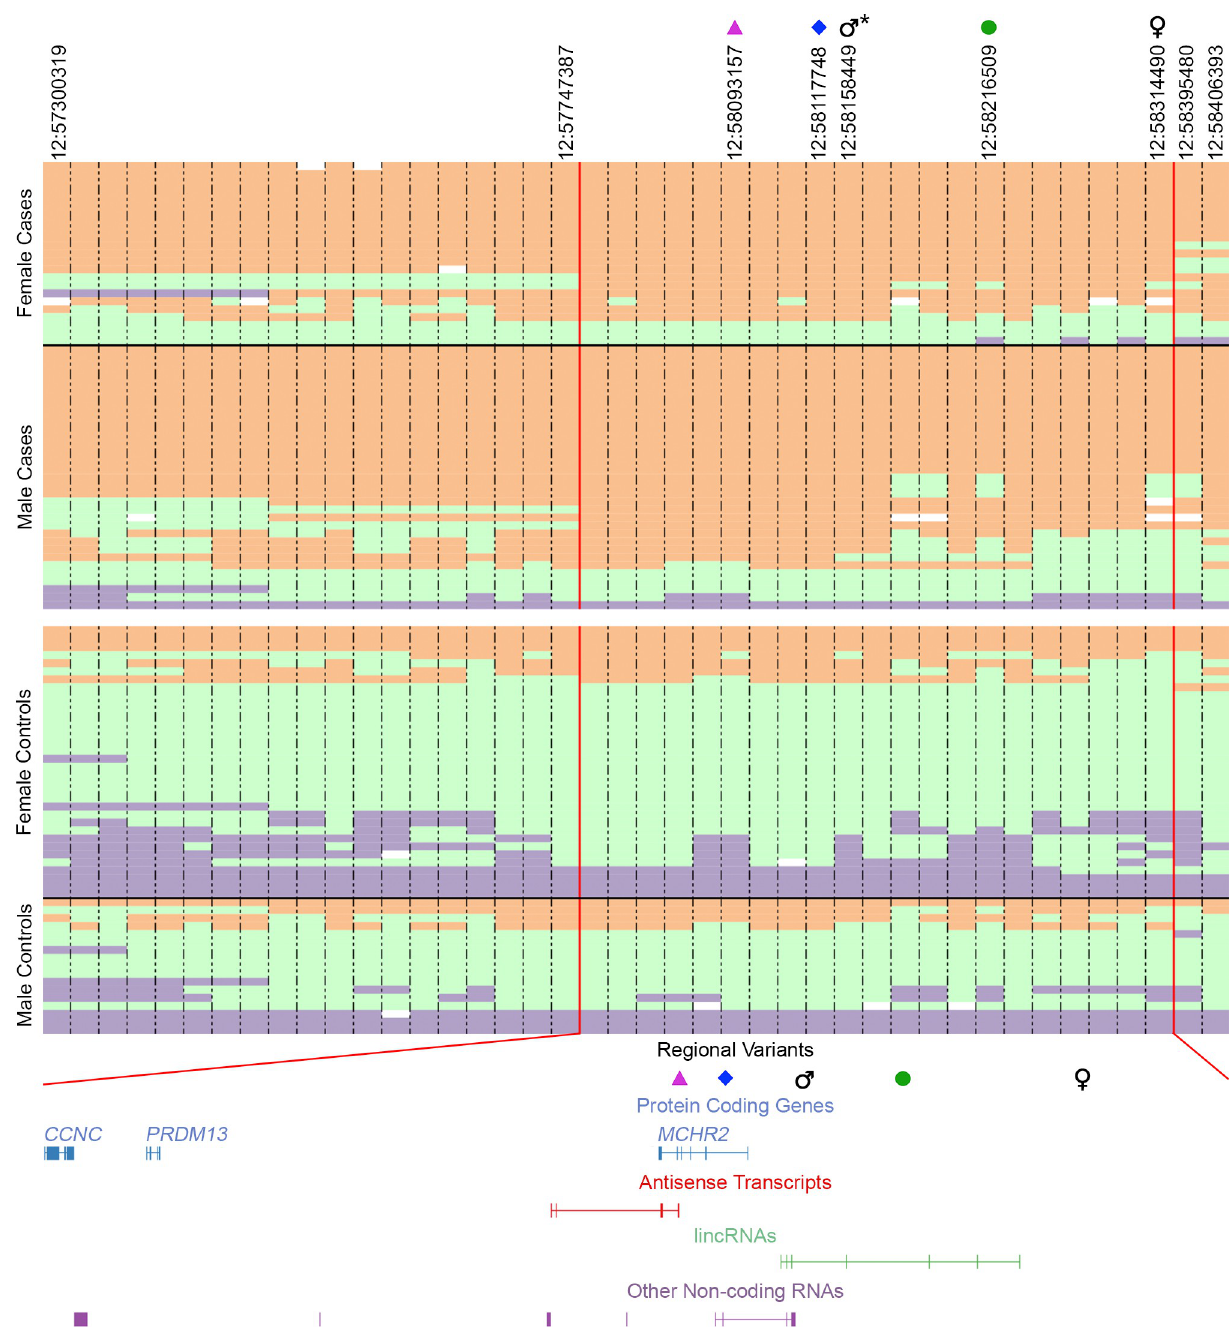
Fig 4. Haplotypes at the CIM-associated locus on chromosome 12. Genotypes from 23 female and 33 male cases (above the white line) and 34 female and 17 male controls are shown for the 1.1 Mb region of high LD. CIM-associated homozygous genotypes are orange while homozygous opposite genotypes are purple, heterozygous genotypes are light green, and missing genotypes are white. Uninformative SNPs were removed. Vertical red lines demarcate a 648 kb interval of high homozygosity among cases, defined by four heterozygous individuals to the centromeric end and three telomerically. CanFam3.1 positions are marked for the antisense transcript SNP (magenta triangle), VNTR (blue diamond), male GWAS lead SNP (male symbol), LINE insertion (green circle), and female GWAS lead SNP (female symbol). Genes and transcripts within the region of high homozygosity are shown below with variant positions noted. � The male GWAS shares the same lead SNP as the original GWAS with both sexes.